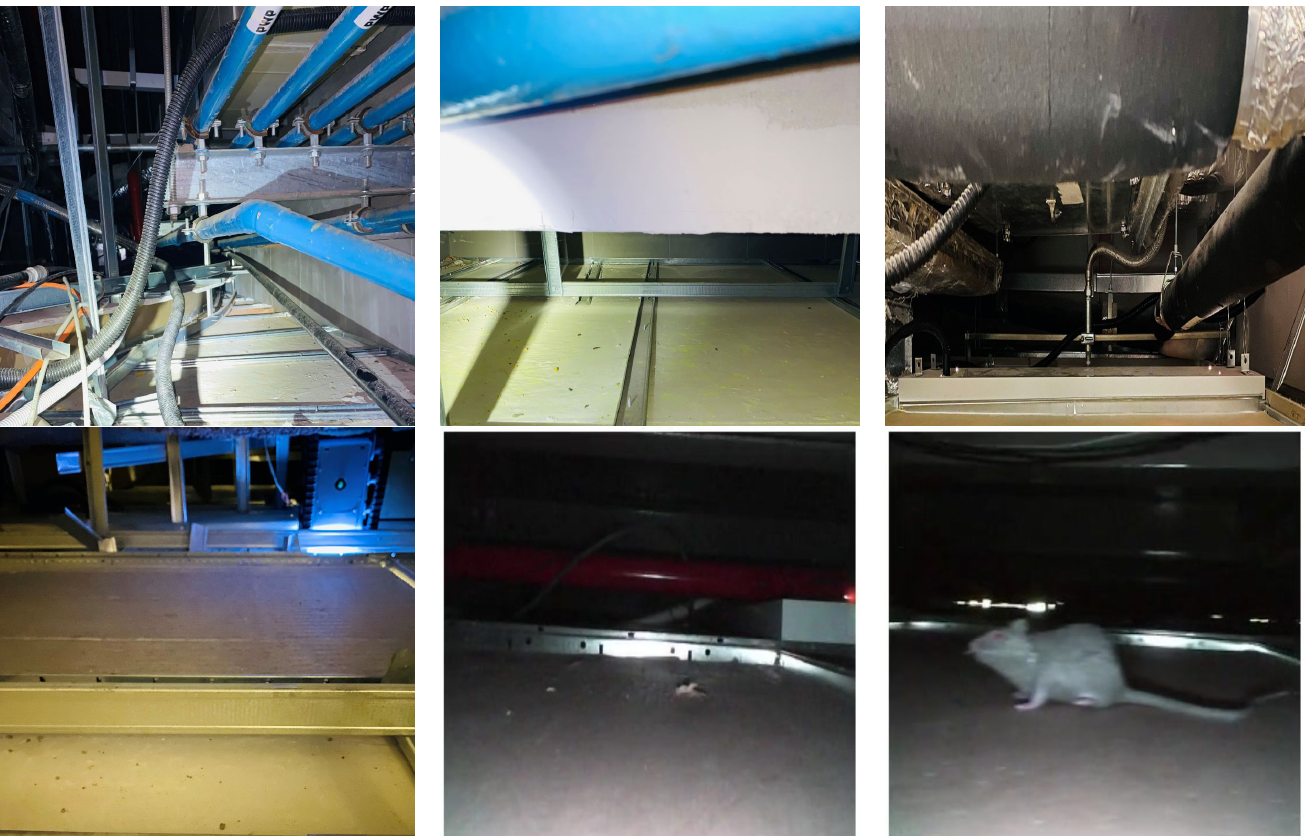
Figure 9. False ceilings environment captured from Falcon